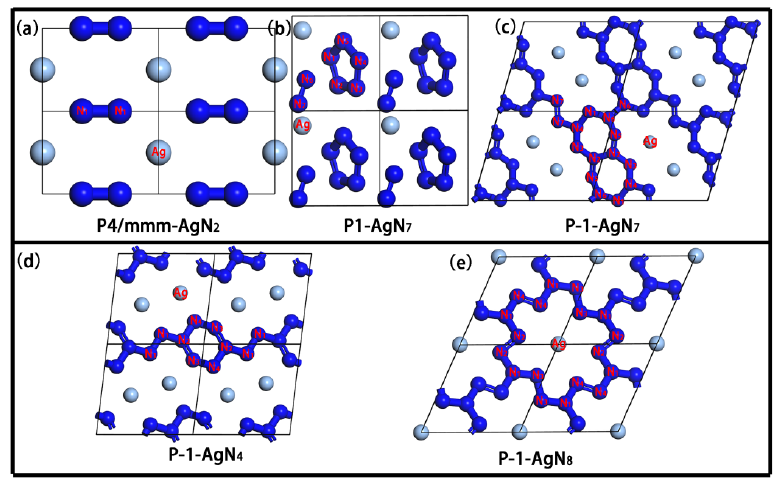
Figure 4. The 2 × 2 × 2 supercell structures of Ag-N compounds: P4/mmm-AgN 2 ( a ), P1-AgN 7 ( b ), P-1-AgN 7 ( c ), P-1-AgN 4 ( d ) and P-1-AgN 8 ( e ).